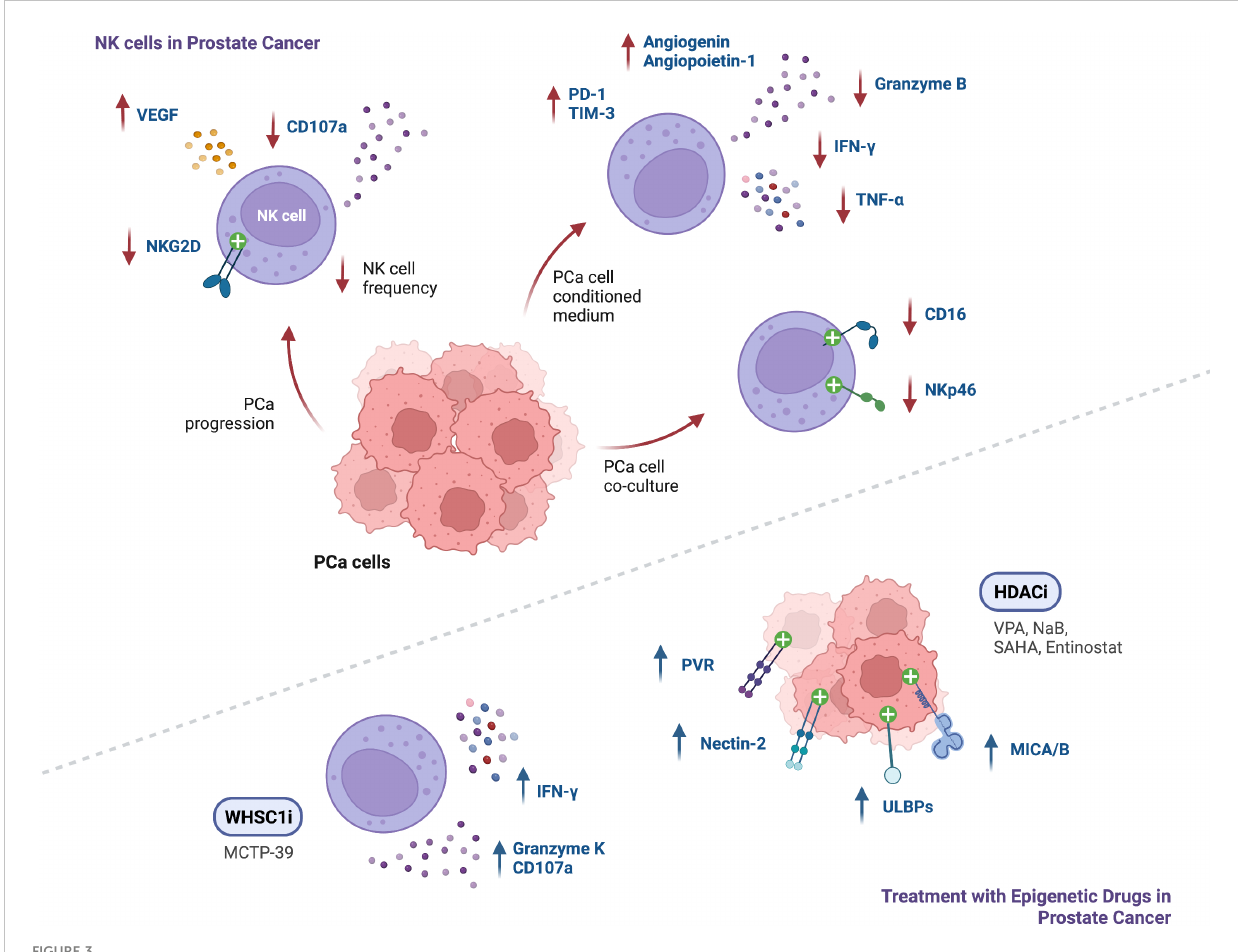
FIGURE 3 Summary of fi ndings regarding NK cell function in the context of PCa, and modulation of NK cell anti-tumor responses following treatment with epigenetic modulating agents ( ↑ - upregulation; ↓ -